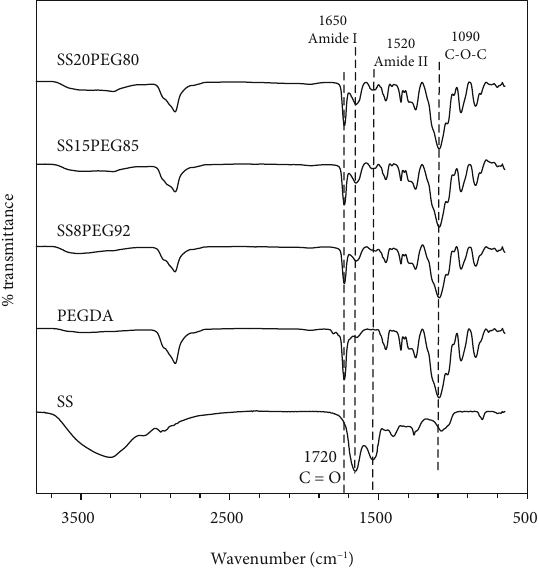
Figure 4: FT-IR spectra of SS raw material, PEGDA hydrogel, and di ff erent SS/PEGDA semi-IPN hydrogel